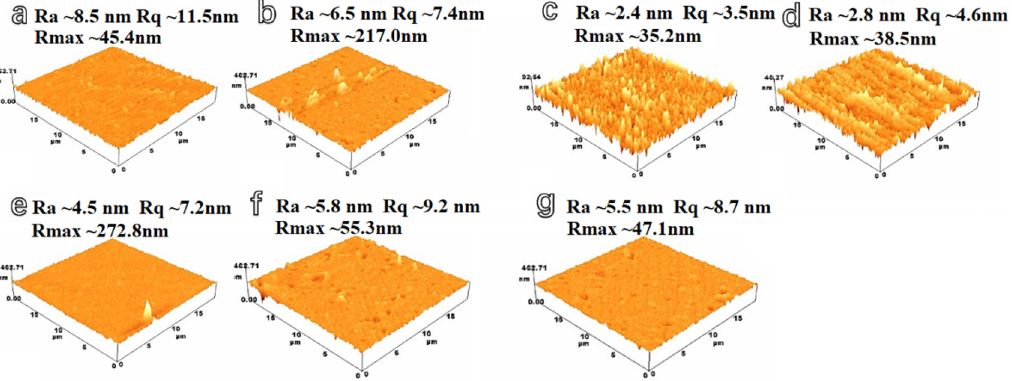
Figure 10. AFM images of wear tracks on the surface of DLC coatings lubrication with different content of Cu nanoparticles in PAO6: ( a ) 0 wt.%, ( b ) 0.05 wt.%, ( c ) 0.1 wt.%, ( d ) 0.3 wt.%, ( e ) 0.5 wt.%, ( f ) 1.0 wt.%, ( g ) 1.5 wt.%.